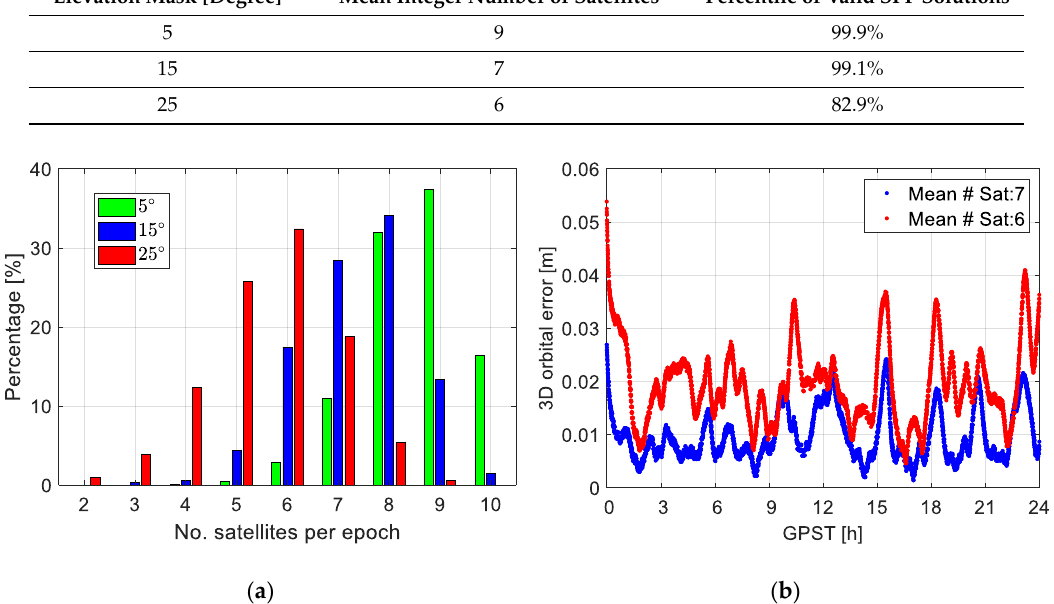
Figure 5. ( a ) Distribution of the satellite numbers per epoch (observing at least P1 and P2 observations) applying different elevation mask angles and ( b ) the corresponding 3D orbital errors of the phase-based reduced-dynamic orbits with a duty-cycle of 100% and mean satellite numbers of 7 and 6.